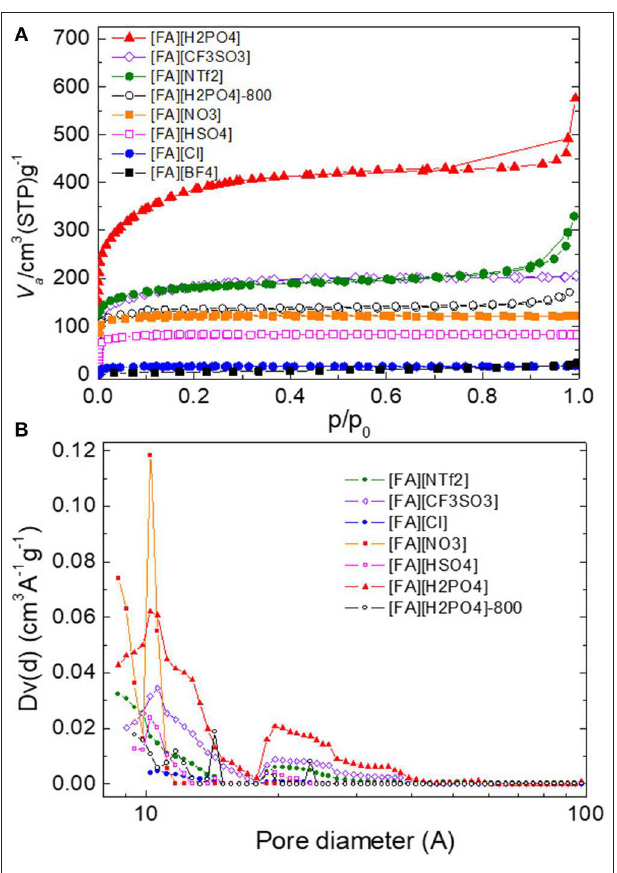
FIGURE 7 | (A) Nitrogen sorption isotherms and (B) pore size distribution of carbon materials derived from [FA][X].